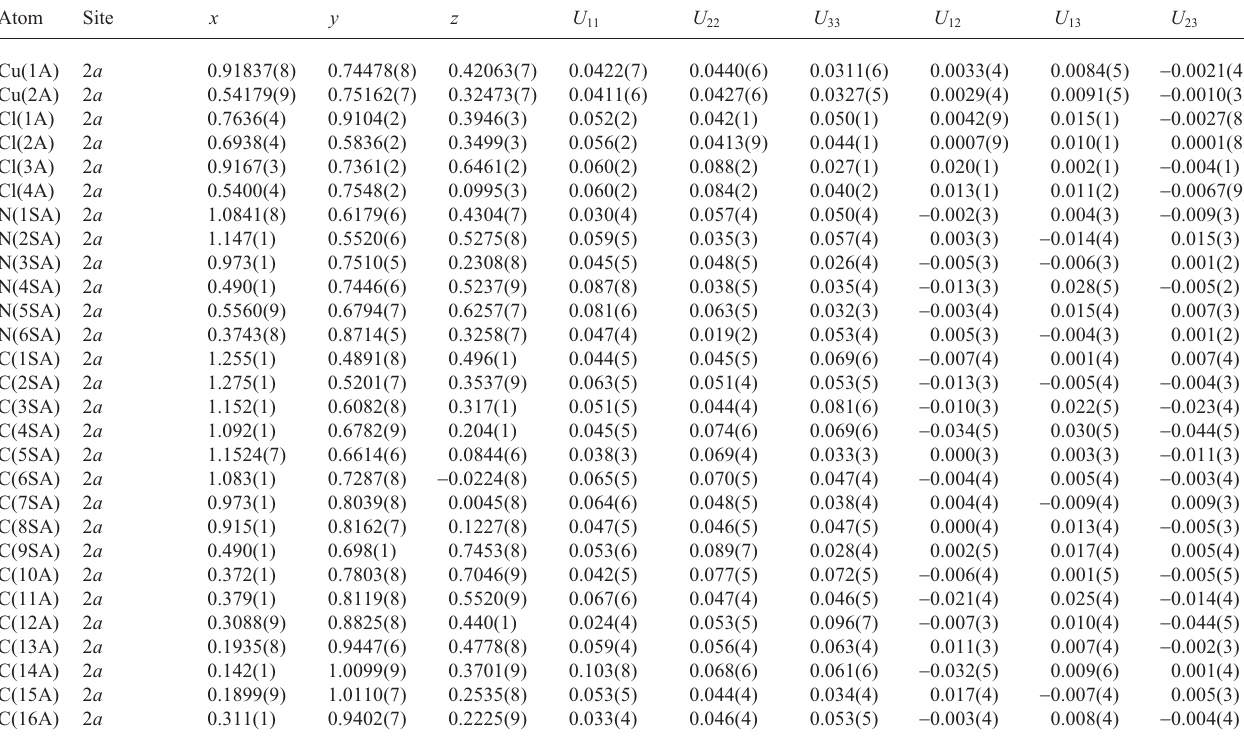
Table 3. Atomic coordinates and displacement parameters (in Å 2 )